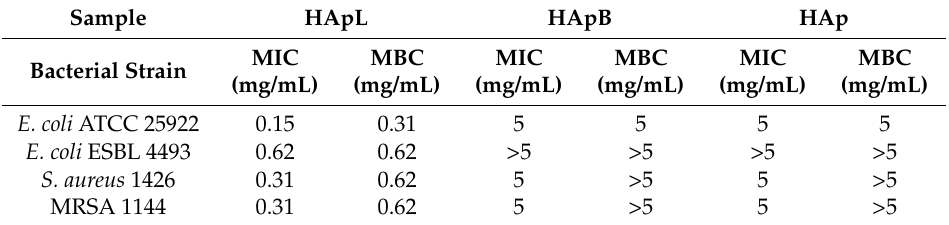
Table 6. Minimum inhibitory concentration (MIC) values and minimum bactericidal concentration (MBC) values determined based on conventional plating method for HAp, HApB and HApL.